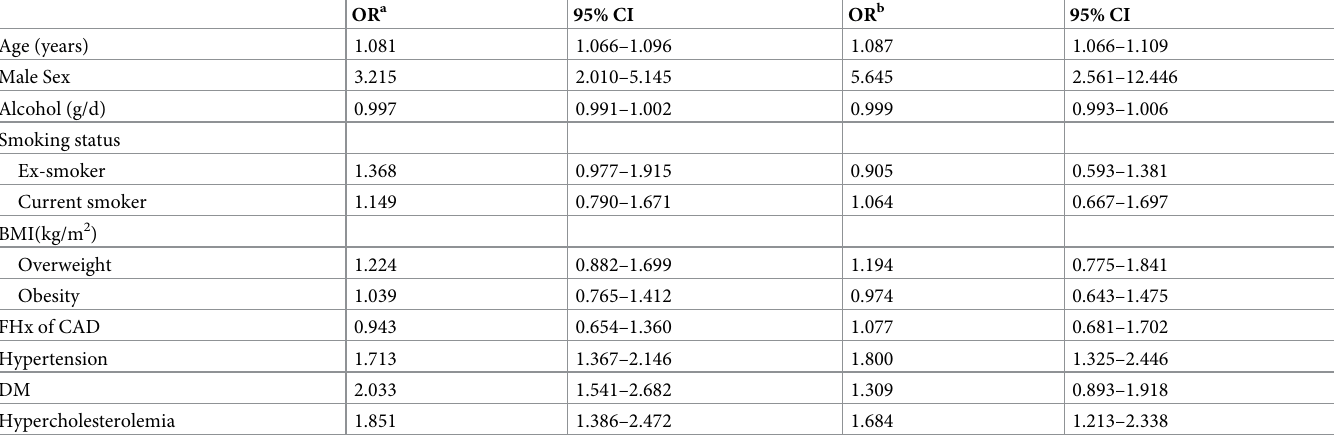
Table 3. Risk factors for high CACS ( � 100) in GERD